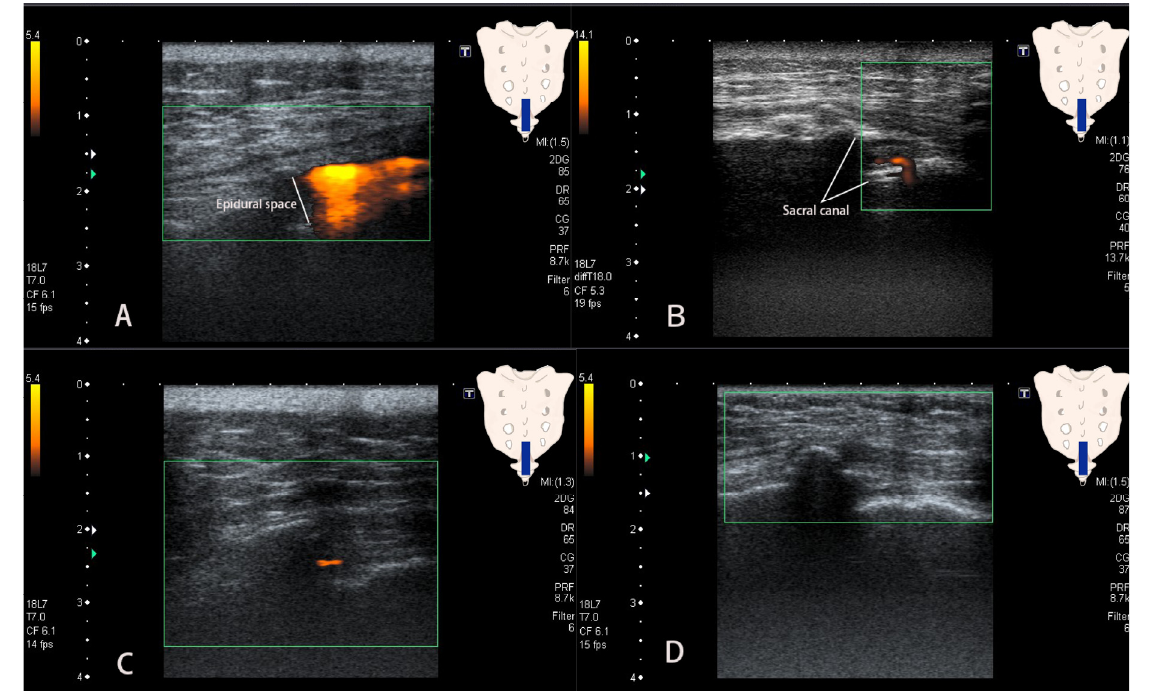
Figure 2. The flow signal in Power Doppler Ultrasound images. ( A ). Patch sign: flow filling the epidural space. ( B ). Earthworm sign: signal comprising a tubular flow descending through the sacral canal floor. ( C ). Tubular sign: signal in the sacral canal that did not fill more than half of its diameters. ( D ). Absent flow sign: no flow